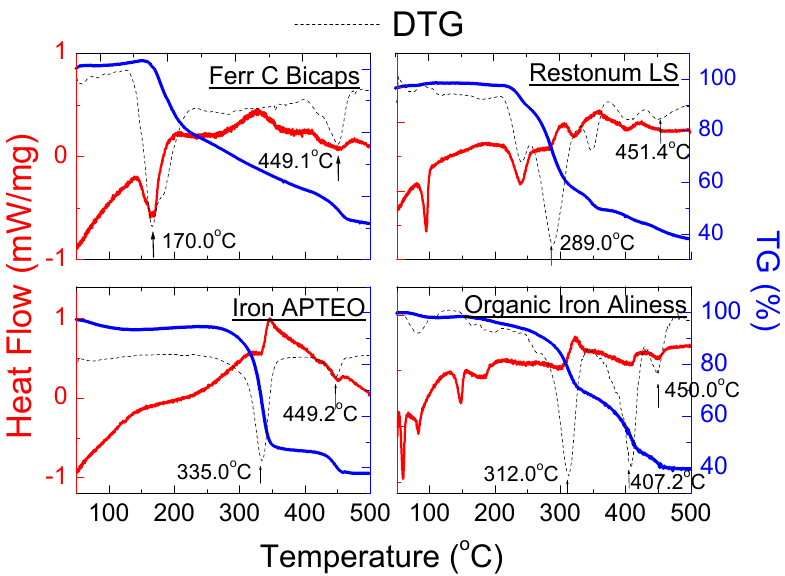
Figure 9. DSC and TG/DTG curves of dietary supplements containing iron (II) fumarate: Ferr C Bicaps , Restonum LS , Iron APTEO and Organic Iron Aliness .